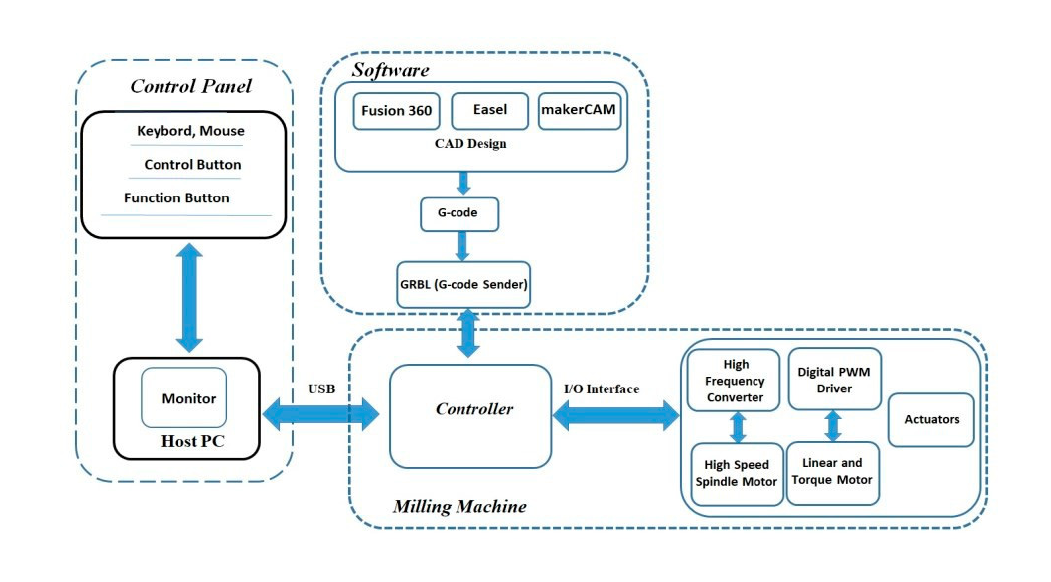
Figure 1. Diagram showing all the necessary components of the milling